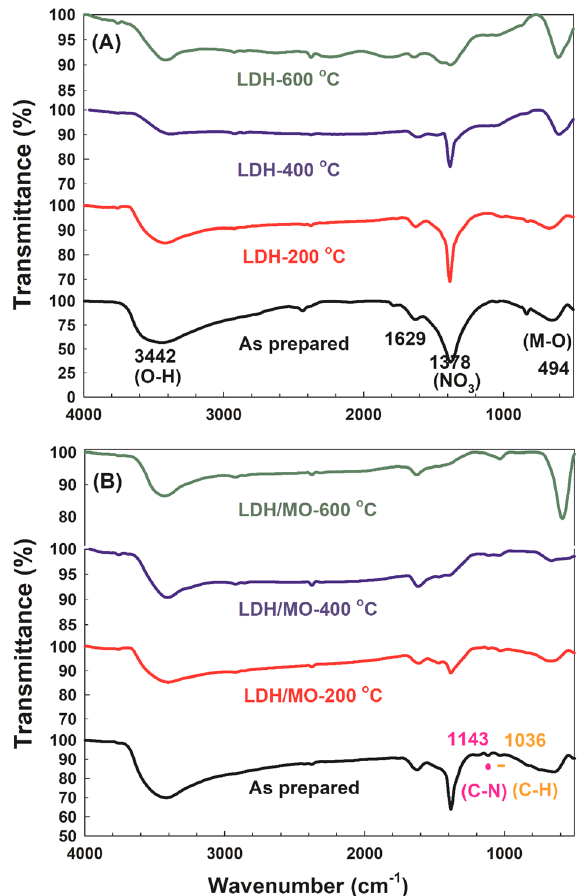
Figure 3. FTIR of LDH samples ( A ) before and ( B ) after adsorption of